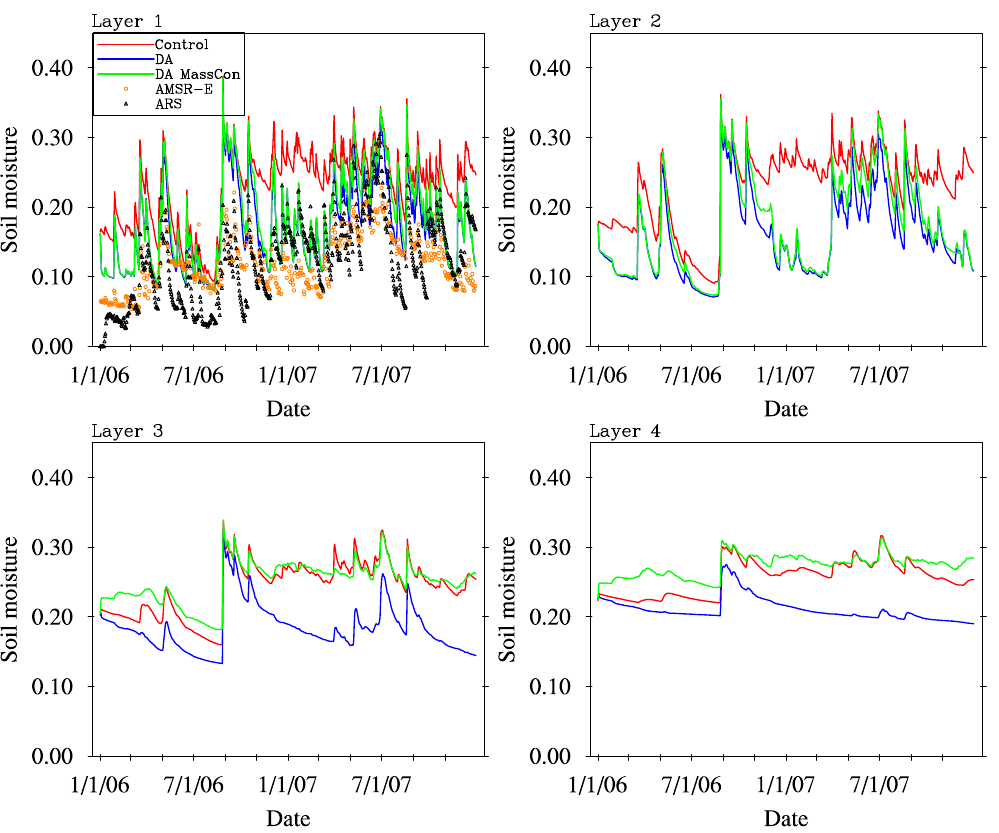
Fig. 3. Time series of basin averaged daily soil moisture (cm 3 cm − 3 ) from Control, DA, and DA MassCon for Noah soil layers 1 to 4. Simulated soil moisture at layer 1 is compared to basin averaged ARS measurements at the 5cm depth and the AMSR-E